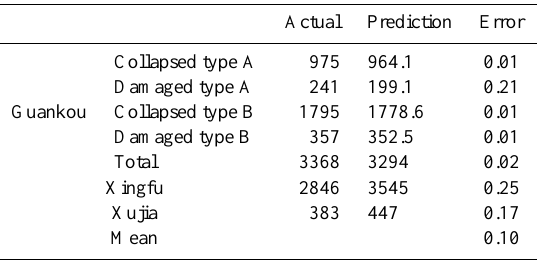
Table 2. Estimating casualties and the actual